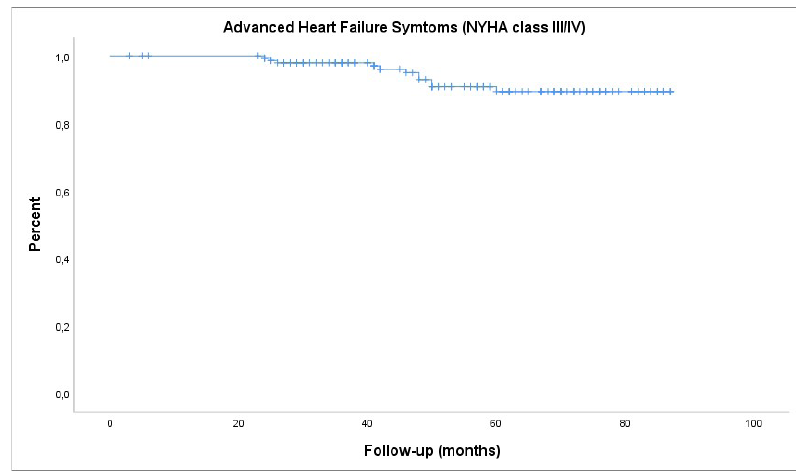
Fig. 3 - Kaplan-Meier analysis of freedom from advanced congestive heart failure in all patients. NYHA=New York Heart Association.